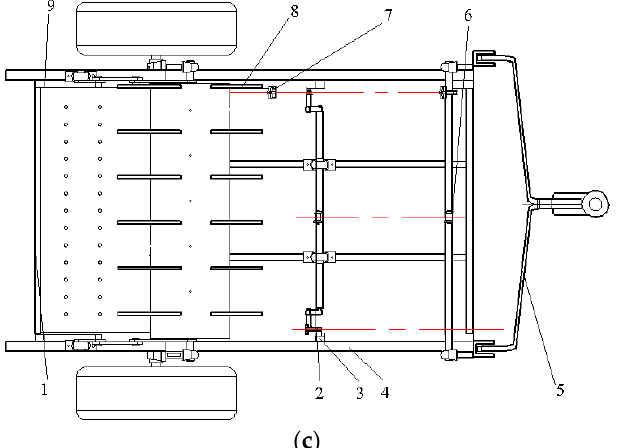
Figure 2. ( a ) The axial side view of four-bar linkage screen device. ( b ) The positive view of the film recovery machine. ( c ) The top view of the film recovery machine. 1. Film collecting box; 2. Ellipse gauge film-picking mechanism; 3. Longitudinal guide rail; 4. Horizontal guide rail; 5. Traction frame; 6. Transmission chain; 7. Clamping conveying mechanism; 8. Stripping roller; 9. Four-bar linkage screen device. The structural diagram of the new film-picking with impurity separation residual film recovery machine.